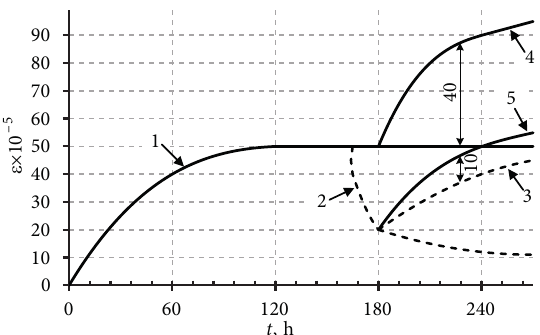
Fig. 2. Changes in concrete block and infill concrete shrinkage deformation development: 1 – blocks before use; 2 – block expansion due to external humidity; 3 – recursive deformations of the block along with infill concrete deformations; 4 – infill concrete deformations when the block is not humid; 5 – infill concrete deformations, which take place together with humid block